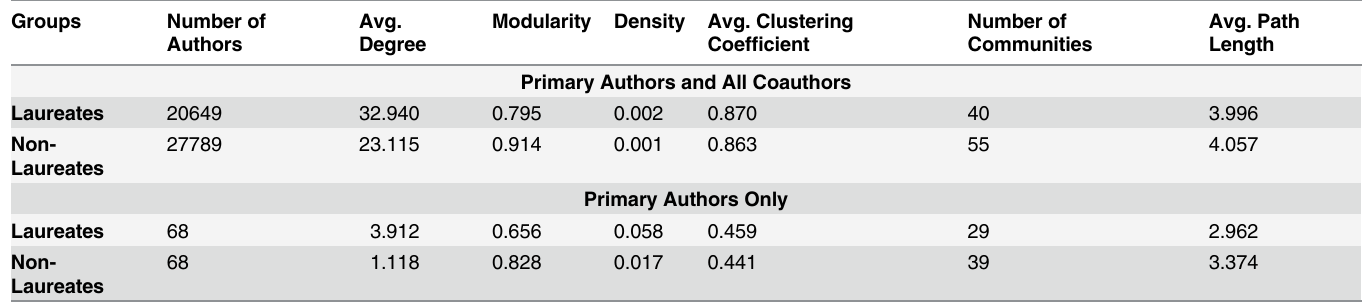
Table 4. Comparative Analysis of Laureate and Non-Laureate Networks with and without